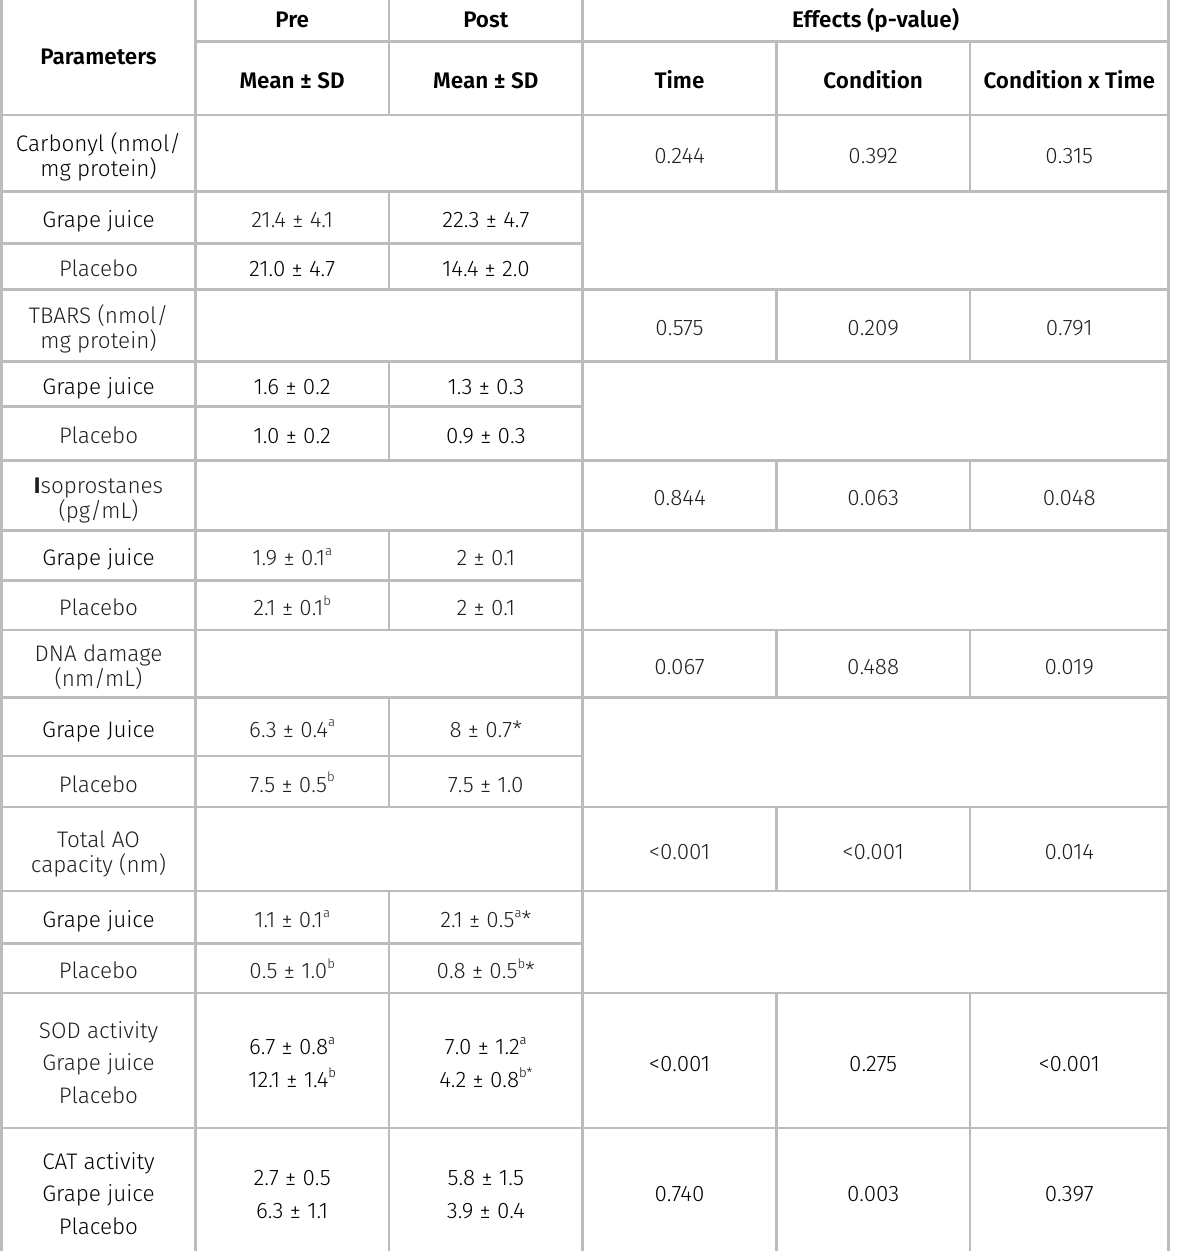
Table III. Oxidative stress parameters before and after a fight simulation in 20 judo athletes. Pre Post Effects (p-value) Parameters Mean ± SD Mean ± SD Time Condition Condition x Time Carbonyl (nmol/ mg